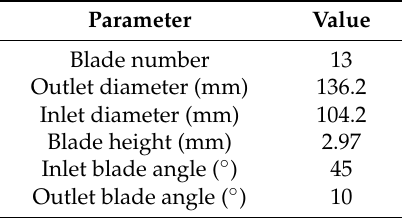
Figure 2. Nozzle profile: ( a ) LED = 10 mm; ( b ) LED = 7 mm; ( c ) LED = 4 mm. Table 2. Detailed geometric parameters of nozzle.